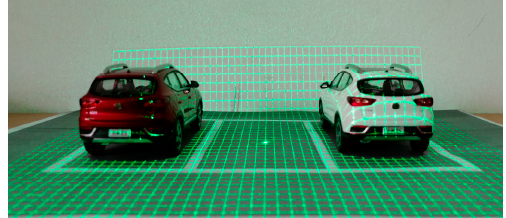
Figure 17. The image of the parking space.